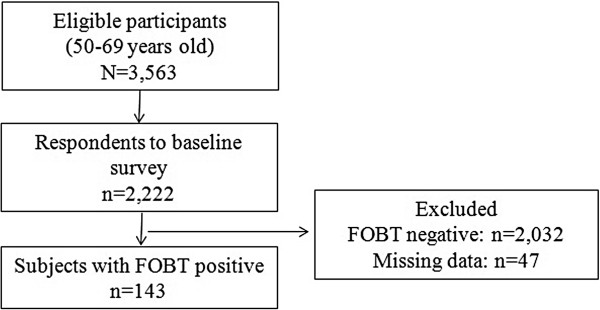
Participation flow.